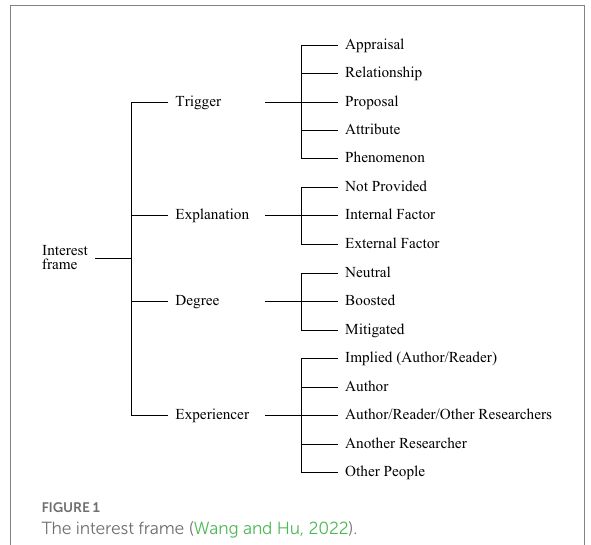
FIGURE 1 The interest frame (Wang and Hu,